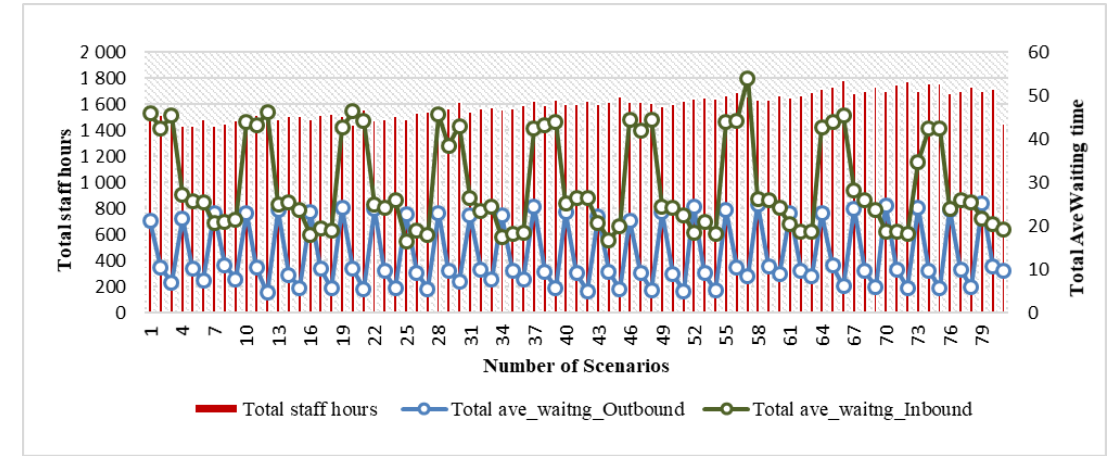
Figure 12. Static allocation method results.